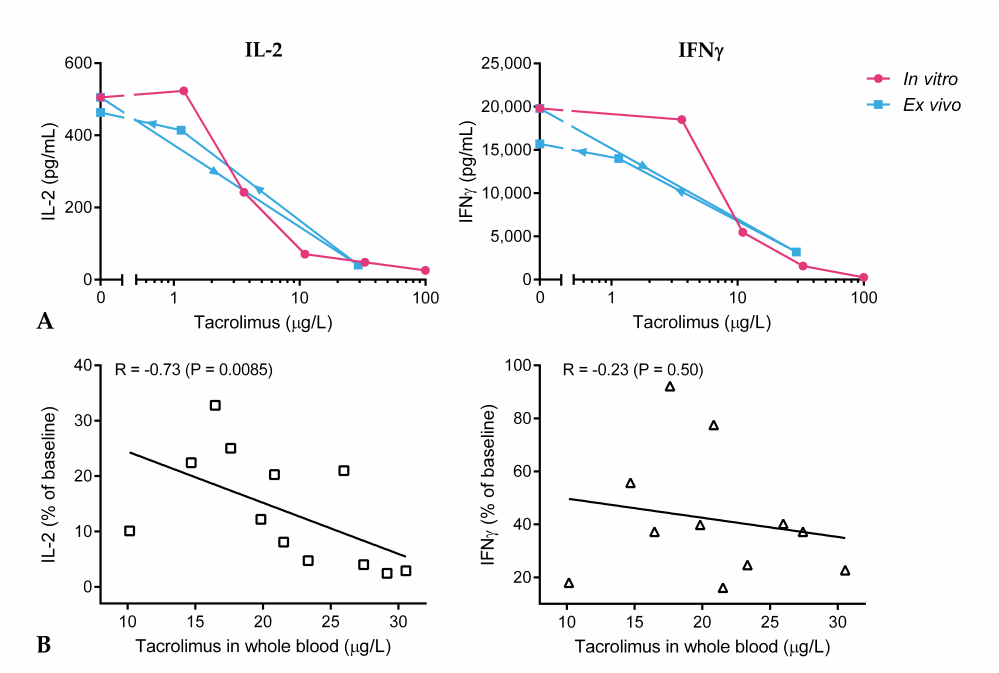
Figure 3. ( A ) Overlay of in vitro and ex vivo tacrolimus e ff ect on cytokine production after 24 h whole blood stimulation with PHA for one subject. In vitro tacrolimus e ff ect: pre-dose cytokine production after incubation with decreasing doses of tacrolimus (100, 33, 11, 3.7, and 1.2 µ g / L). Ex vivo tacrolimus e ff ect: cytokine production at 0 h, 1.5 h, 48 h, and 96 h after dosing. Arrows indicate time lapse. ( B ) Correlation between tacrolimus concentrations at 1.5 h post-dose in whole blood and relative IL-2 and IFN γ